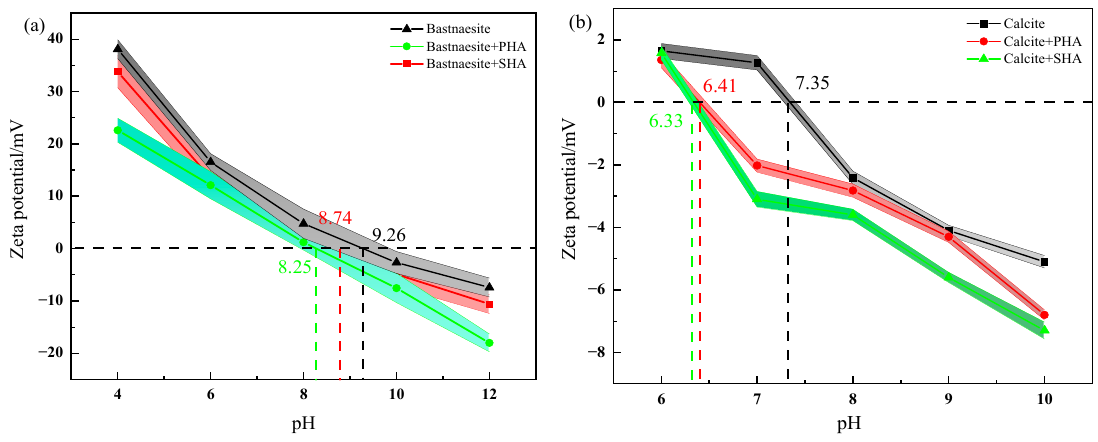
Figure 6. Zeta-potential results of bastnaesite ( a ) and calcite ( b ).